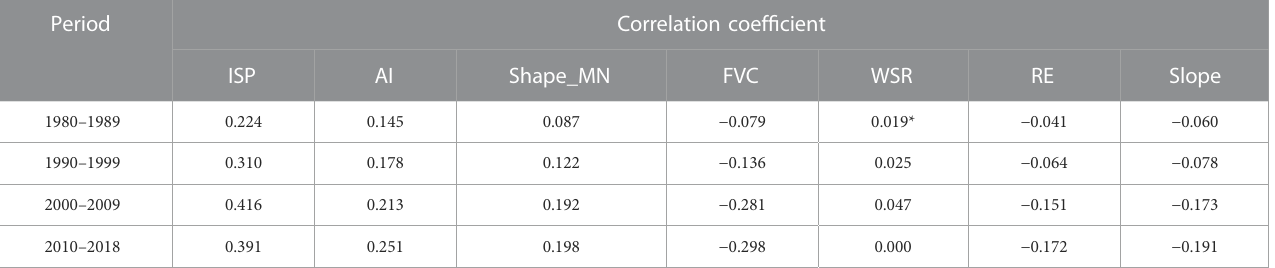
TABLE 3 Results of correlation analysis of the influencing factors of flooding in the GBA. Period Correlation coef fi cient